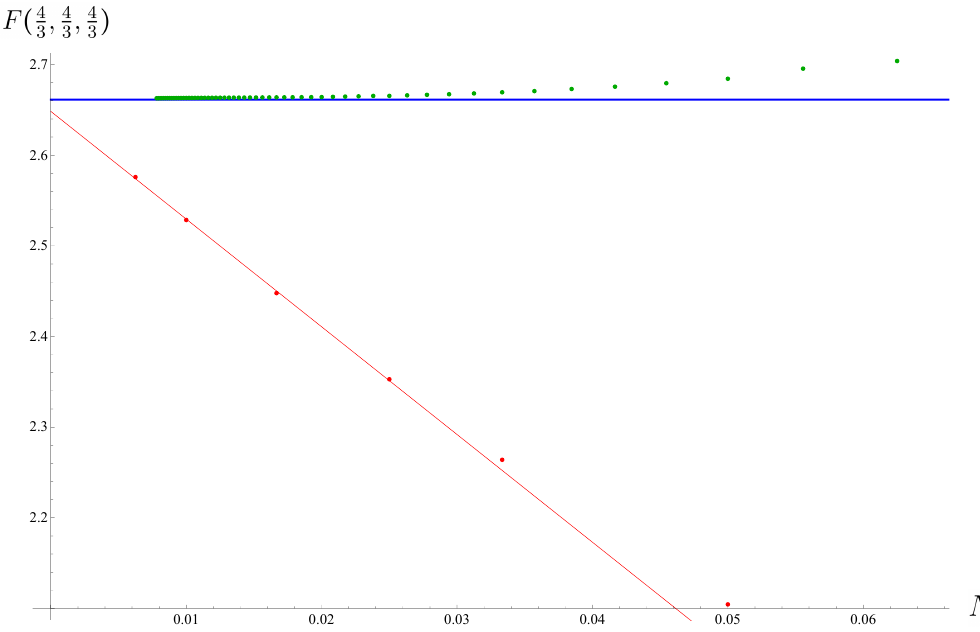
Figure 4. The maximum of the amplitude at the symmetric point s 0 = t 0 = u 0 = 4 of the) number of interpolation points/coefficients N − 1 (green). The vertical axis correspond to infinite number of interpolation points for the primal or coefficients for the dual. We do not assume the existence of a pole at threshold which would give the horizontal line. The values are multiplied by a factor π/ 4 to match the normalization in the literature, e.g. see